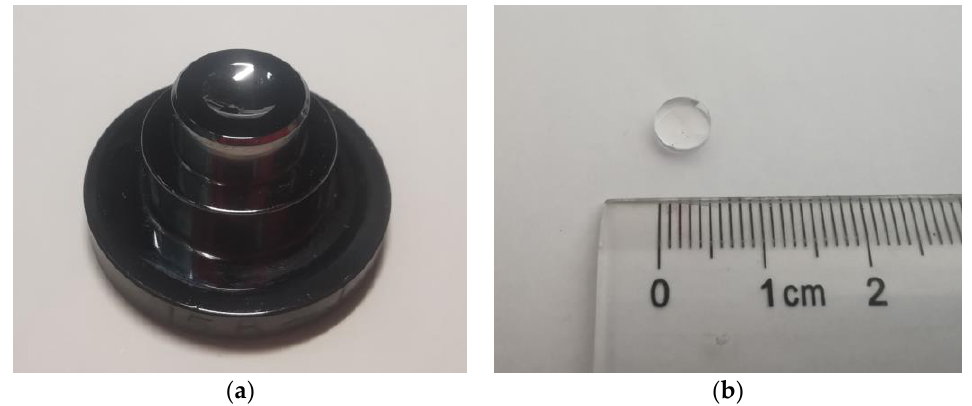
Figure 8. Schematic diagram of PGM process. ( a ) Single station glass molding machine ( b ) PGM process conditions.